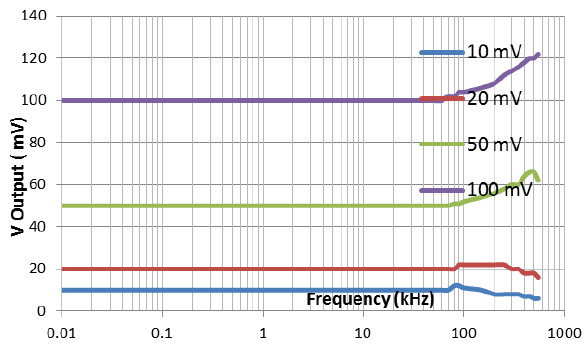
Figure 10. The stability of root mean square (RMS) to direct current (DC) circuit of output voltage to DC against frequencies. DC against